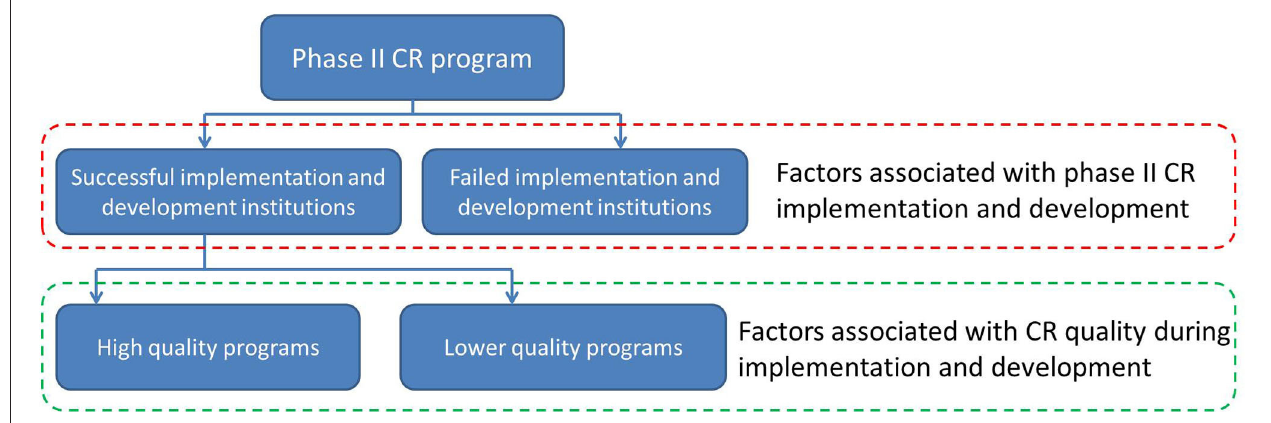
FIGURE 1 | Data analysis flow